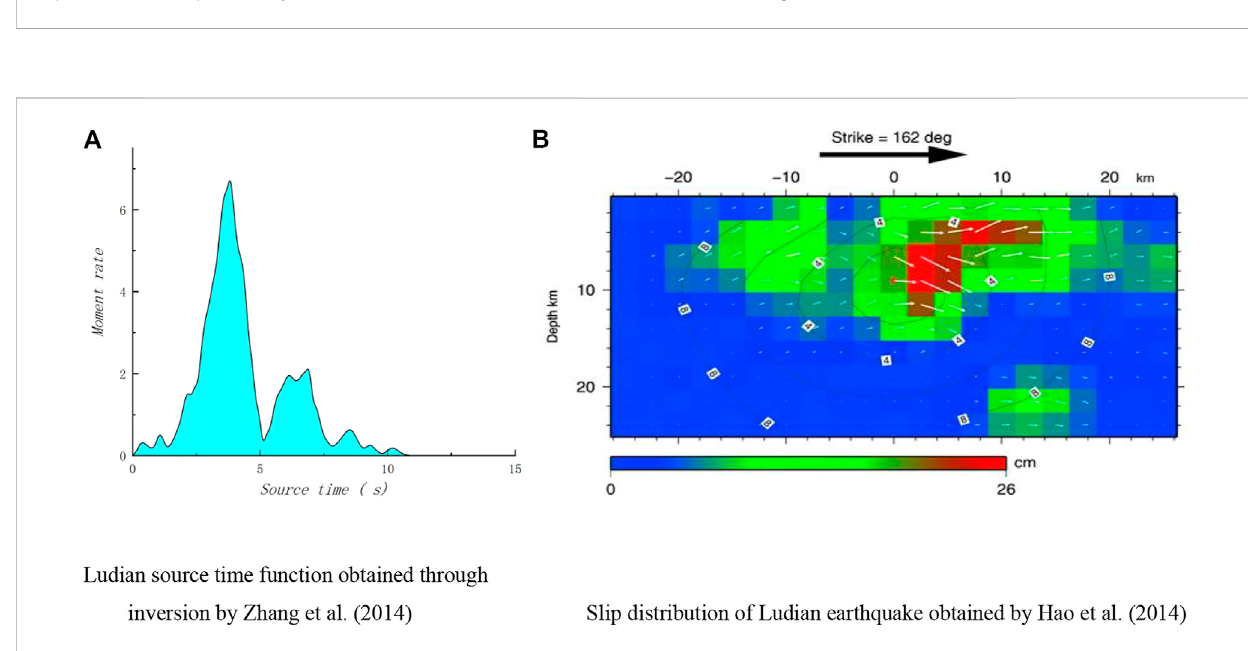
FIGURE 3 Source model of the Ms 6.5 2014 Ludian earthquake. (A) Ludian source time function obtained through inversion by Zhang Z. G et al. (2014). (B) Slip distribution of Ludian earthquake obtained by Hao et al.